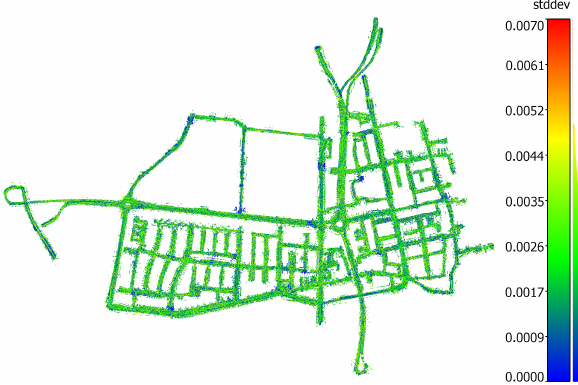
Figure 5. Precision Map (temperature scale, blue for 0 mm and red for 7 mm)